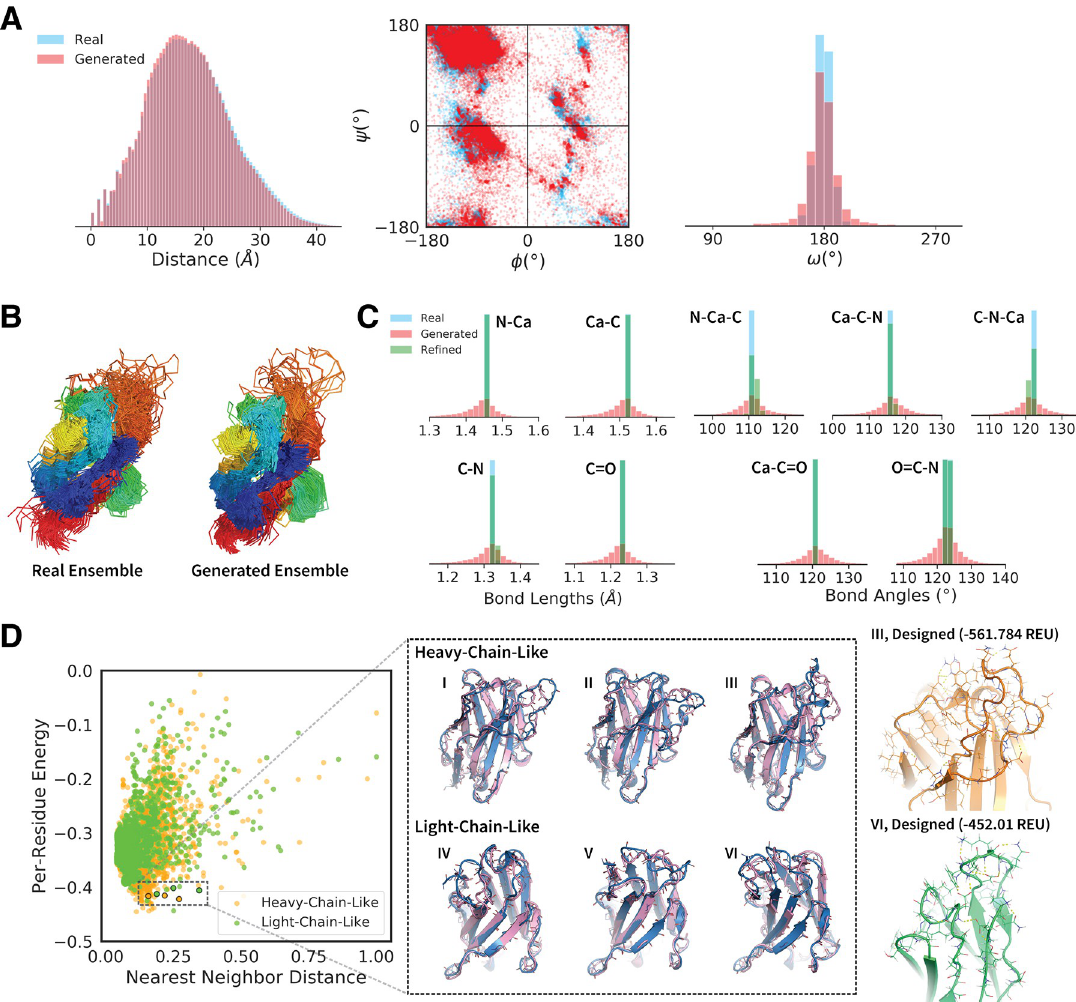
Fig 3. Analysis of Generative Sampling. Data for 500 of randomly selected non-redundant training samples and generated structures. (A) Overlays of the pairwise distance and Ramachandran distributions of the real and generated data. (B) A comparison of the real and generated structural ensembles. (C) Overlays of the bond length and bond angle distributions of the real, generated and refined data. (D) The left panel shows a plot of the post-refinement per-residue centroid energy against normalized nearest neighbor distance for the generated structures. The nearest neighbor distance is computed as the minimum Frobenius distance between the generated distance matrix and all distance matrices in the training set. Each point is colored based on whether the nearest neighbor is a heavy or light chain Ig. The center panel shows an overlay of the generated structures (pink) and their nearest neighbors (blue) in the training set. These six structures were selected using a combination of centroid energy, nearest neighbor distance, heavy/light classification, and manual inspection. The right panel shows sequence design results for structures III and VI. The energies in the left panel are centroid energies, while the energies in the right panel are full-atom Rosetta energies using the ref2015 score function.